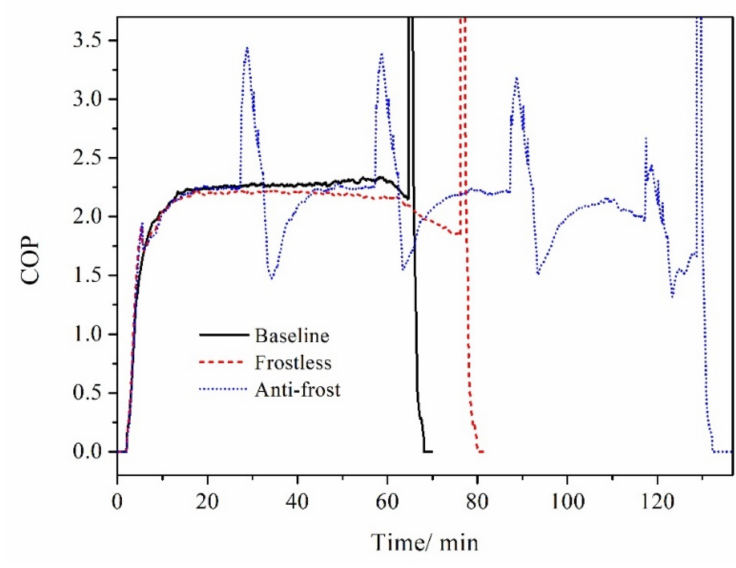
Figure 9. COP of the ASHP for the three modes.